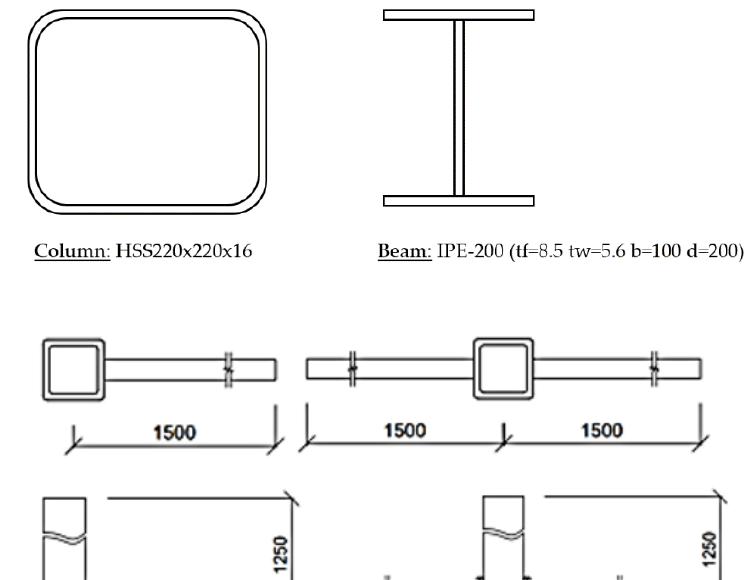
Figure 4. Details of end-plate [mm] and lateral view of EP-HSS moment connection [mm]. 2. Finite Element (FE) Modeling The numerical study was performed using the software ANSYS software [21] considering the constitutive laws of material, geometrics nonlinearities, contact nonlinearities, and boundary conditions. Large displacements were considered in the simulations due to the high rotation levels reached in the connections. The Incremental Newton–Raphson method was used, which the